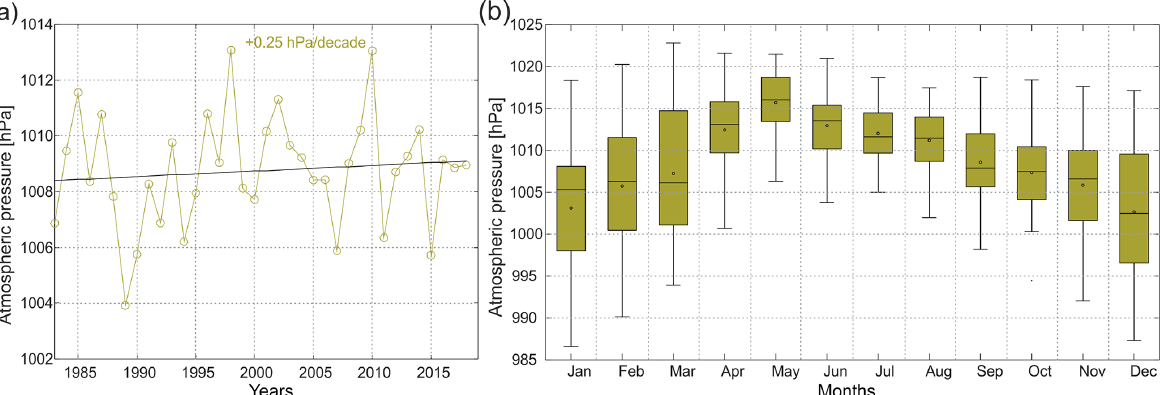
Figure 5. (a) Variability of mean annual air pressure reduced to sea level in 1983–2018 at Hornsund. (b) Variability of mean annual air pressure reduced to sea level in 1983–2018 at Hornsund.